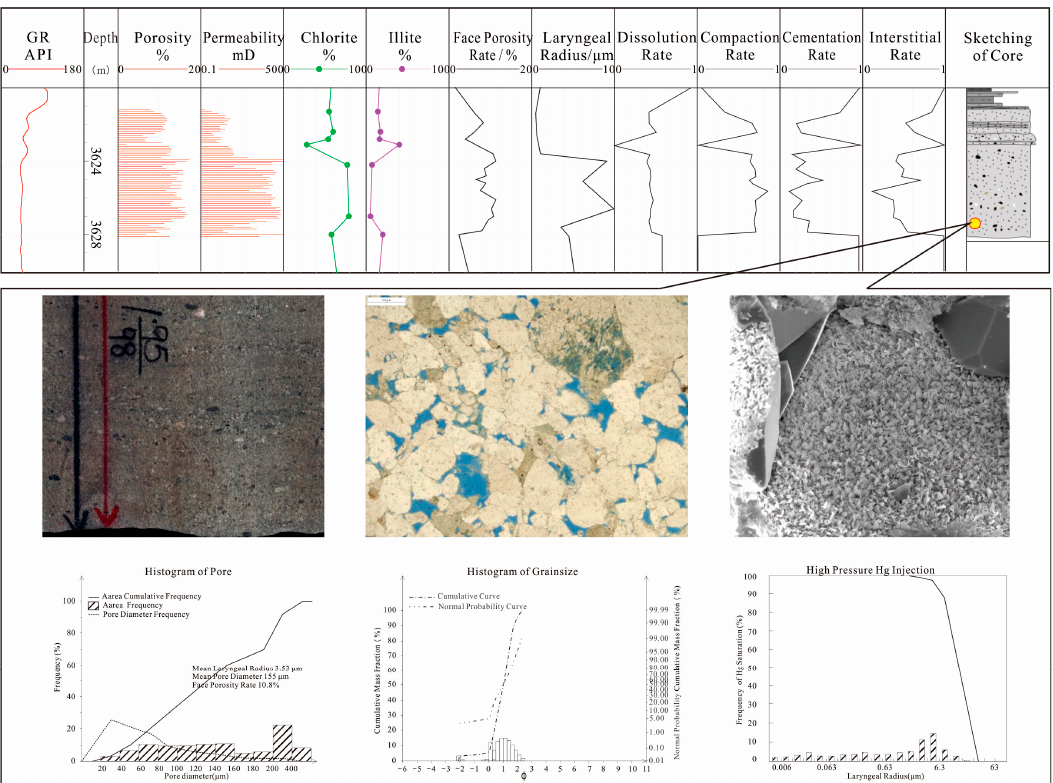
Figure 14. Section and petrographic photographs of type I chlorite sedimentary facies in H3 of well X-2.